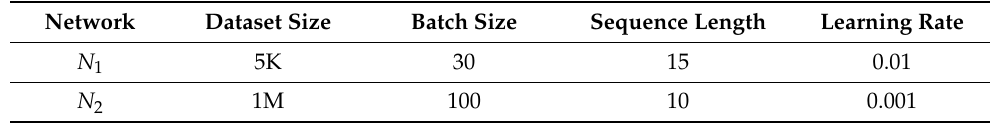
Table 5. Training parameters used for Tomita’s 5th grammar and its